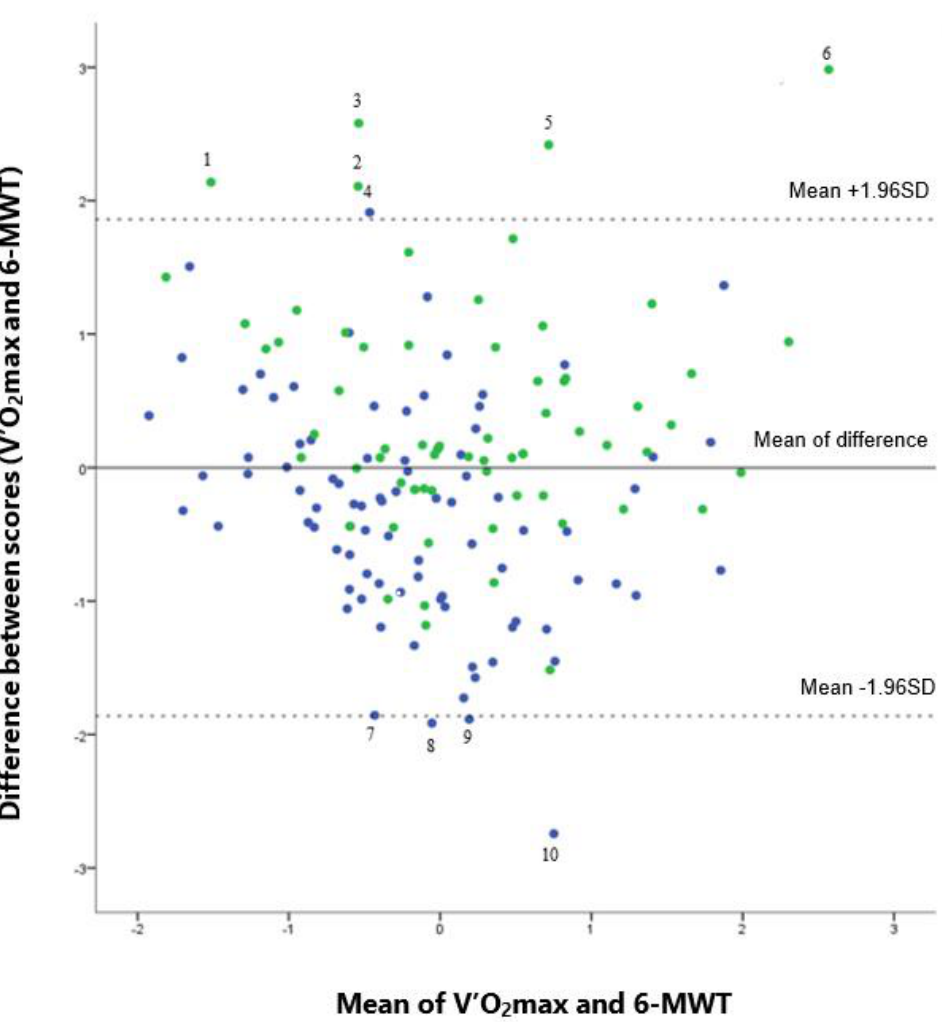
Figure 2. Bland and Altman plot showing the agreement between the V’O 2 max and the Six-Minute Walk Test (6MWT) distance. Legend: Green points for normal exercise capacities: Maximal result of exercise test is greater or equal to 80% of the reference value. Blue points for lower exercise capacities: Maximal result of exercise test is less than 80% of the reference value .